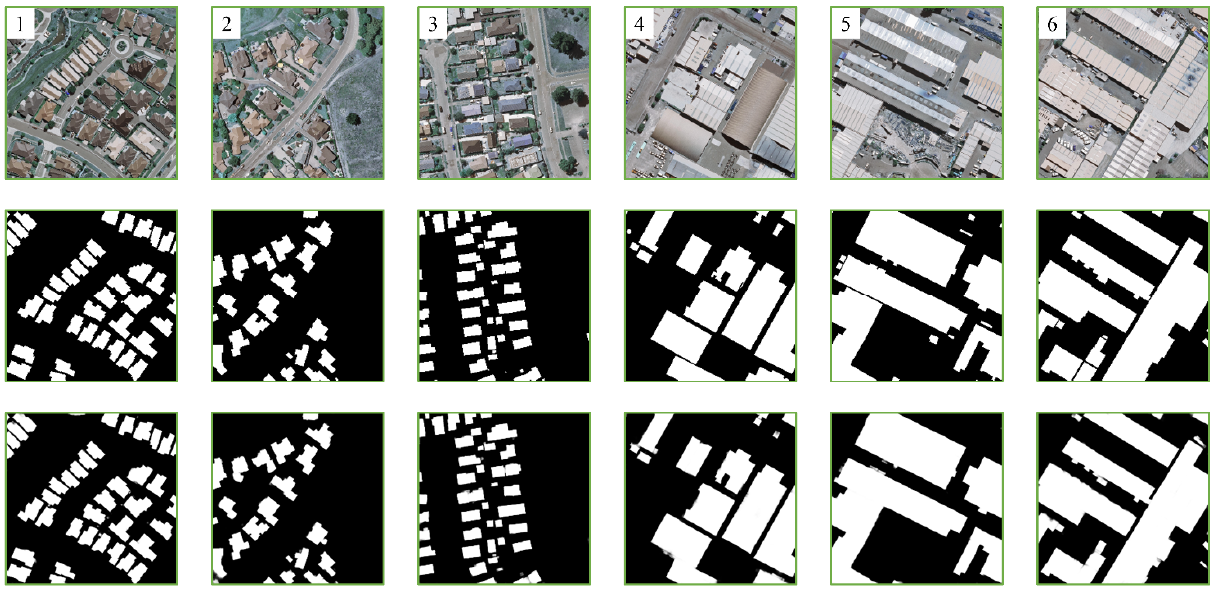
Figure 8. Building extraction results of the B-FGC-Net on the WHU building dataset. The first to third rows are the original images, labels, and results, respectively. The numbers 1–6 represent the index in which the image is